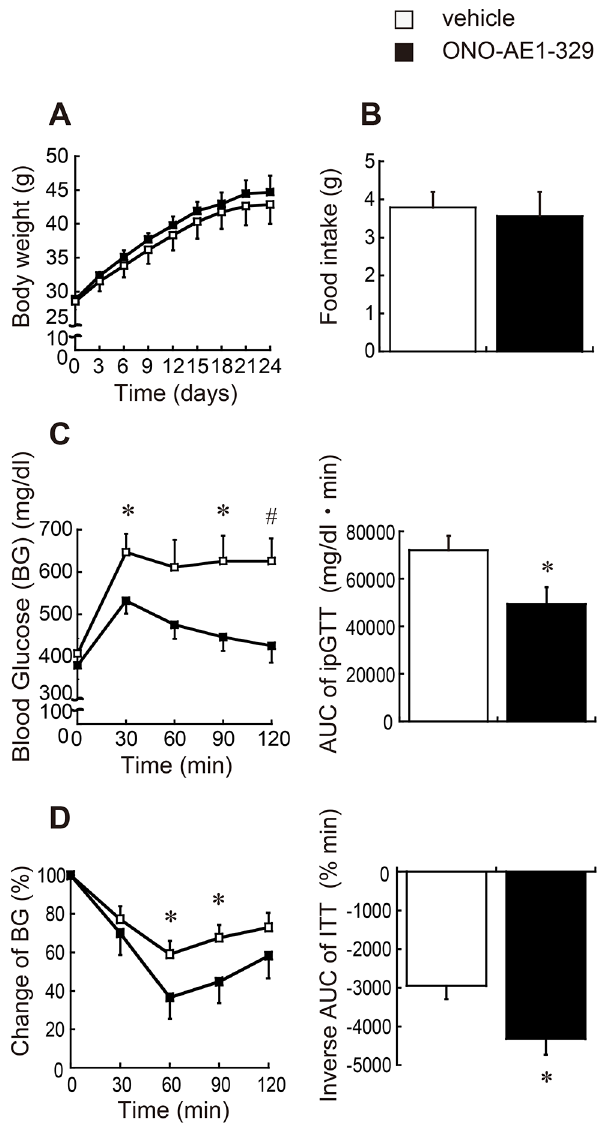
Fig 1. Effects of EP4 activation on glucose tolerance and insulin resistance. Seven-week-old male db/ db mice subcutaneously received either the EP4-selective agonist ONO-AE1-329 (0.3 mg/kg) or vehicle twice a day for 4 weeks. (A) Change in body weight during the study period (n = 8 each). (B) Amount of food intake (n = 8 each). (C) Results of glucose tolerance test: left, time-course of blood glucose levels; right, area under curve (AUC) (n = 7 – 8 each). (D) Results of insulin tolerance test: left, time-course changes of blood glucose levels; right, the inverse AUC (n = 13 each). All values are mean ± SEM. * p < 0.05; ] p < 0.01 vs.